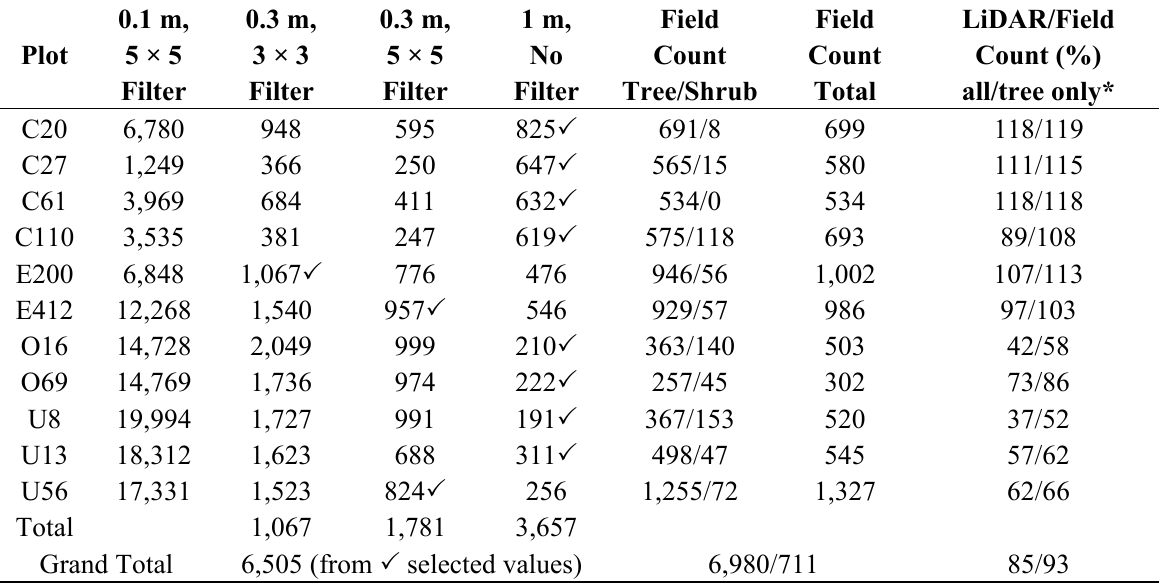
Table 5. Delineated stem counts resulting from watershed segmentation using various CHM resolutions compared to field measured vegetation. Checked numbers indicate the resolution and filter method that best matched field count